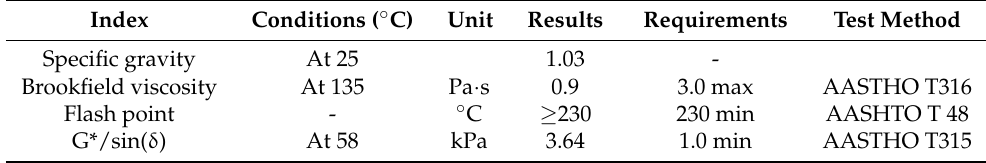
Table 2. Properties of the PG70-28.